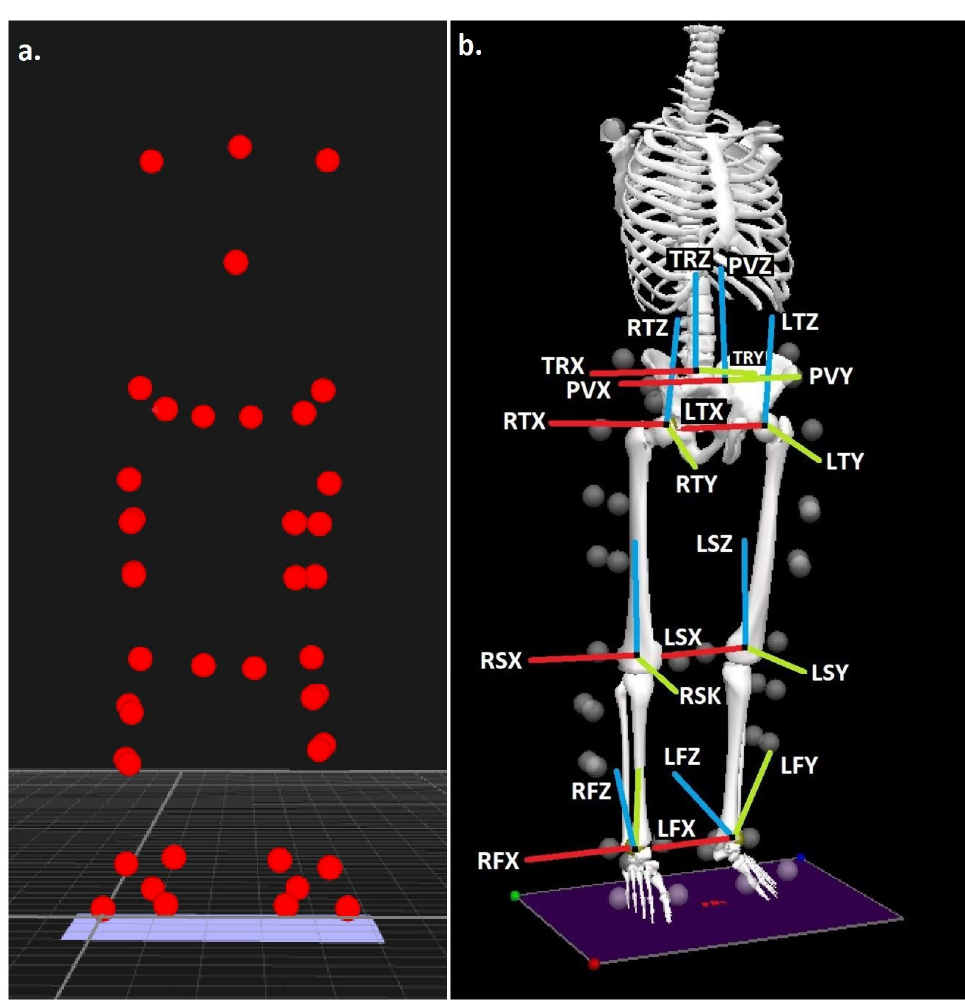
Figure 1. ( a ) Experimental marker locations and ( b ) trunk, pelvis, thigh, shank, and foot segments, with segment co-ordinate system axes (R = right and L = left), (TR = trunk, P = pelvis, T = thigh, S = shank, and F = foot), (X = sagittal, Y = coronal, and Z = transverse